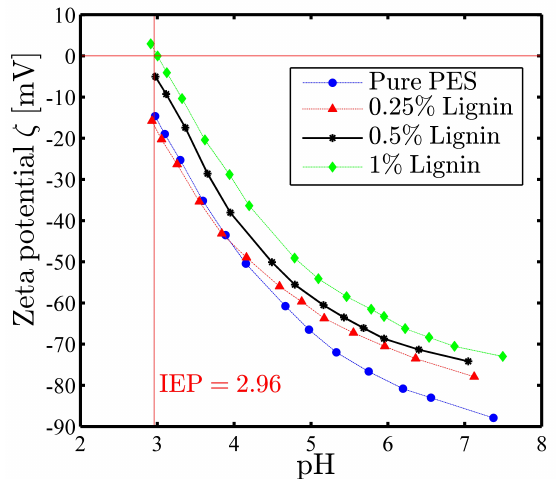
Figure 4. The effect of different wt % of lignin as an additive on the surface charge of modified